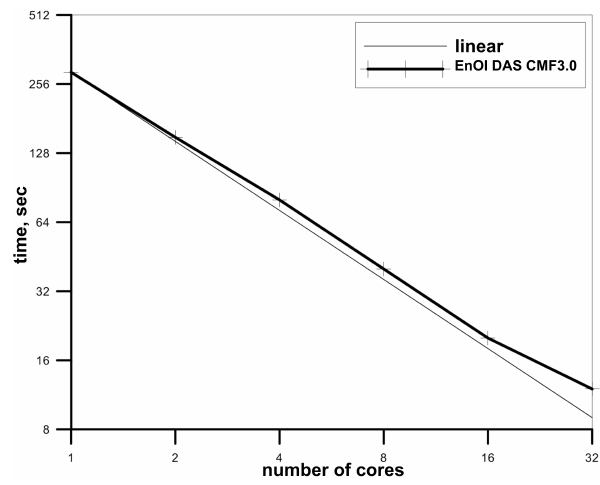
Figure 10. Scalability of the EnOI method in the context of the CMF3.0 DAS service at the assimilation of 10 4 points on the Lomonosov supercomputer (Moscow State